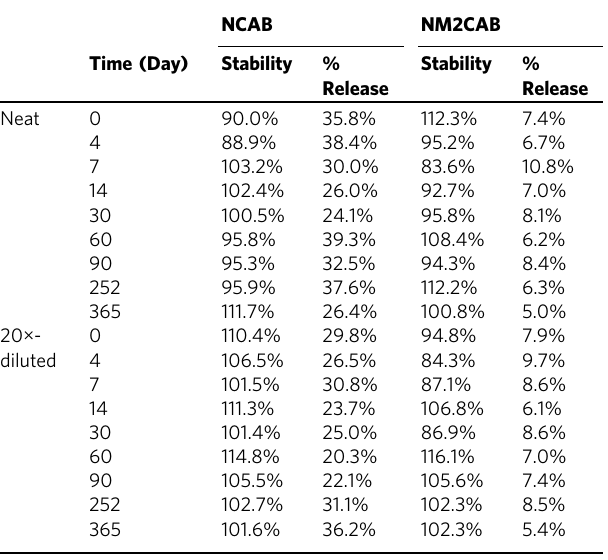
Table 2 Storage stability of NCAB and NM2CAB